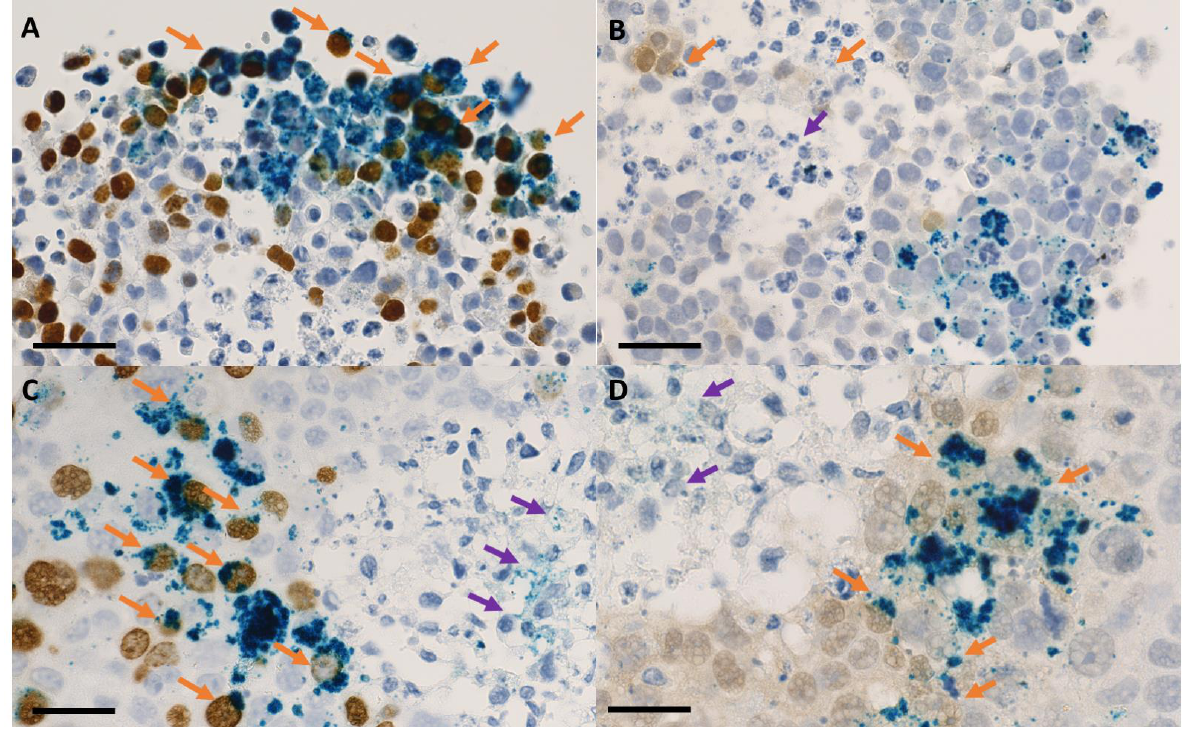
Figure 8. High magnification of bright-field microscopy images — spheroid sections that were previously incubated for 48 h with 200 μg/mL IONP DOX : ( A , B ) HeLa, ( C,D ) FaDu; immunohistochemical staining of proliferative areas using bromodeoxyuridine ( A , C ), of hypoxic areas using pimonidazol ( B , D ); light blue hematoxylin, dark blue IONP, dark brown proliferative cells, light brown hypoxic cells; measure bar is 25 μm; orange arrows highlight nanoparticles internalized in proliferative/ hypoxic cells and purple arrows highlight nanoparticles internalized in necrotic cells.